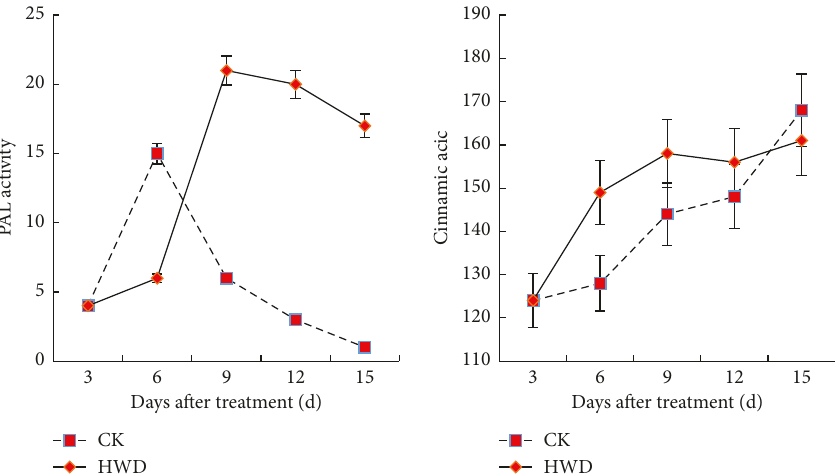
Figure 9: The effect of heat treatment on the activity of PAL, C4H, and the content of cinnamic acid and coumaric acid in fruits. The vertical line in the figure represents the standard error ( ±